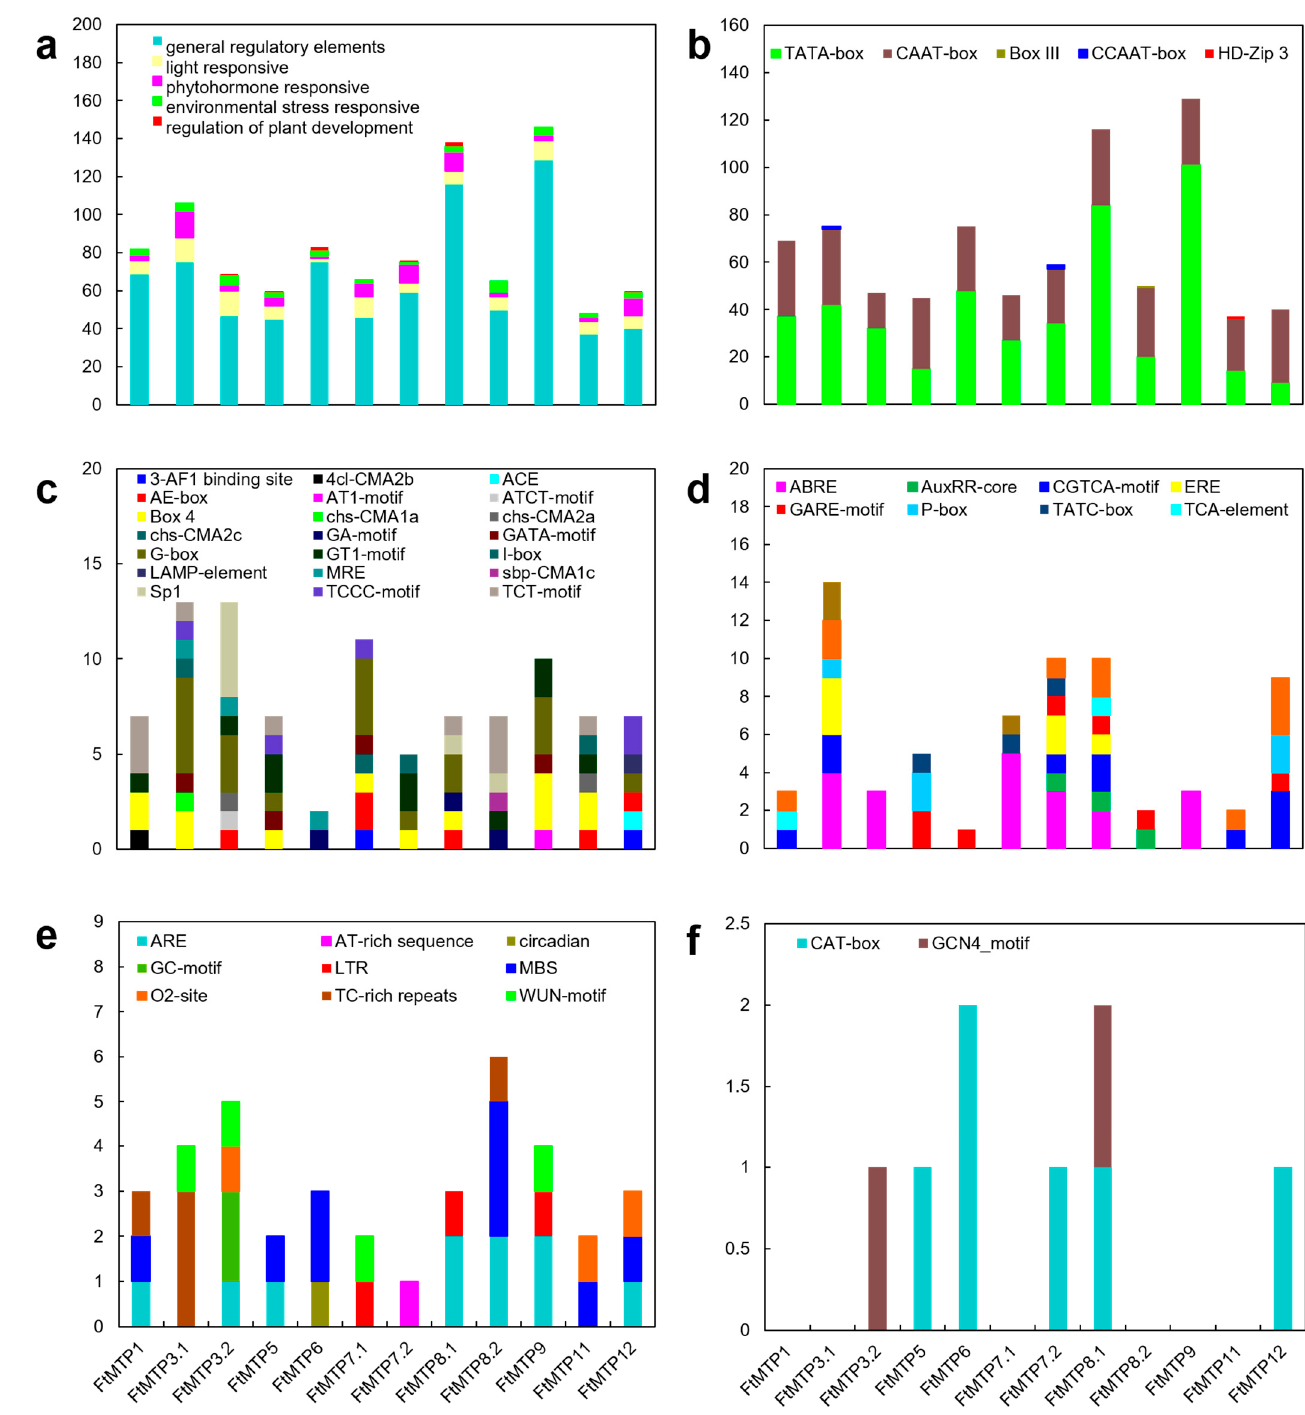
Figure 4. Cis -regulatory elements ( CREs ) of FtMTP genes. ( a ) members and numbers of CREs of FtMTP genes; ( b ) members and numbers of general regulatory elements of FtMTP genes; ( c ) members and numbers of light-responsive elements of FtMTP genes; ( d ) members and numbers of phytohormone responsive elements of FtMTP genes; ( e ) members and numbers of environmental stress-responsive elements of FtMTP genes; ( f ) members and numbers of regulation of plant development elements of FtMTP genes. The value used in the vertical axis in these figures represented the number of corresponding cis -regulatory elements.